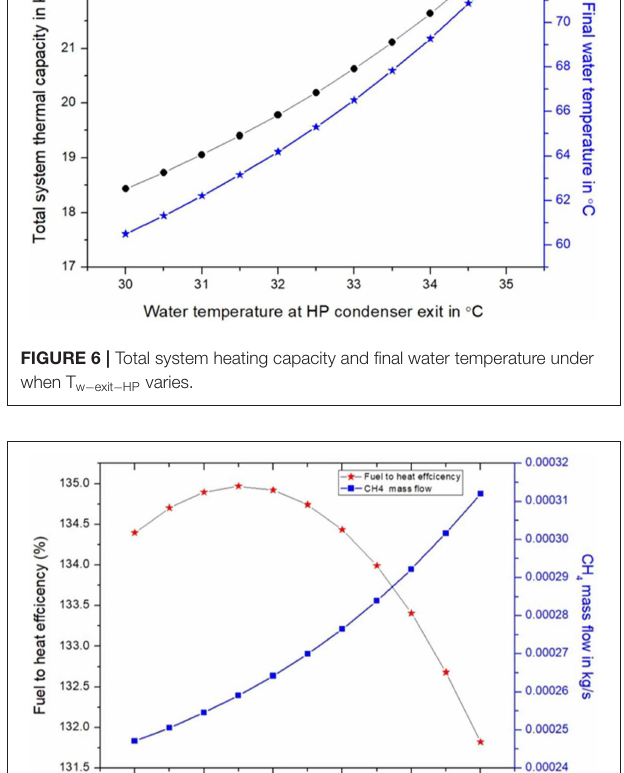
flow for both cycles increase with the increase in the T w − exit − HP as shown in Figures 4 , 5 .